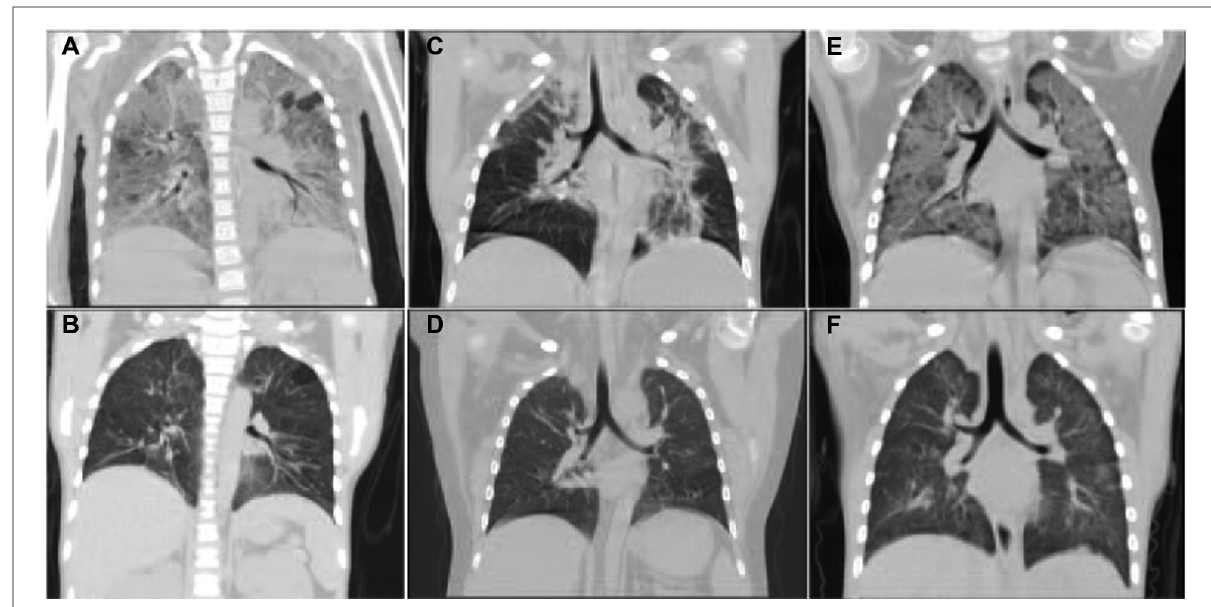
FIGURE 1 The CT images of lungs in three PNS cases with PCP. It showed that extensive exudation in both lungs was improved signi fi cantly after antifungal treatment. ( A,B ) The CT images of lungs before and after anti-fungal treatment in Case 1. ( C,D ) The CT images of the lungs before and after treatment in Case 2. ( E,F ) The CT images of lungs before and after treatment in Case